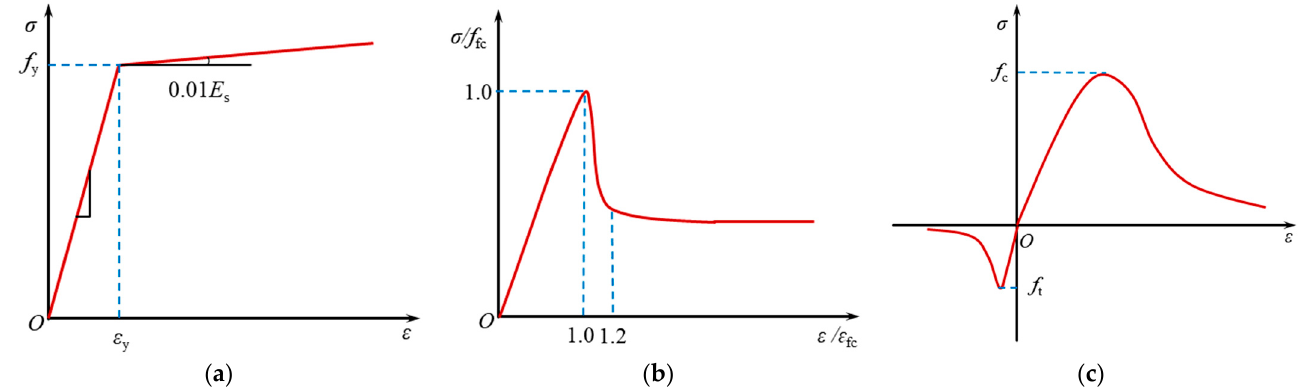
Figure 17. The constitutive model: ( a ) steel; ( b ) foam concrete; ( c ) concrete.